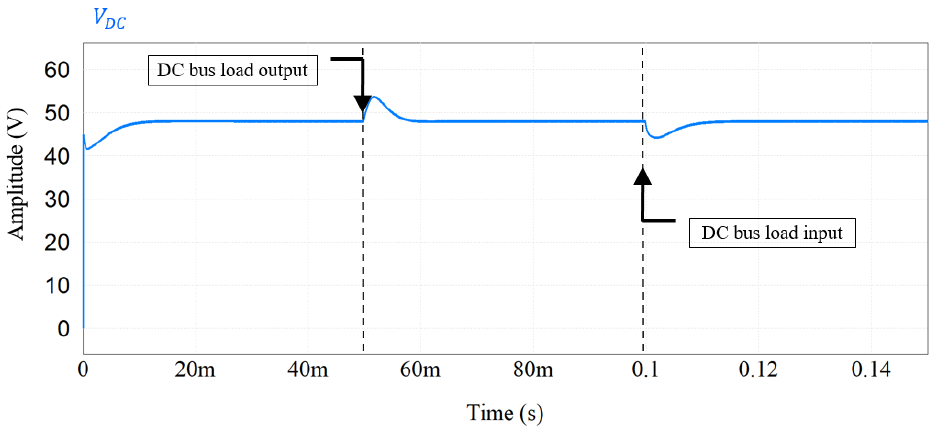
Figure 9. DC Bus Voltage with